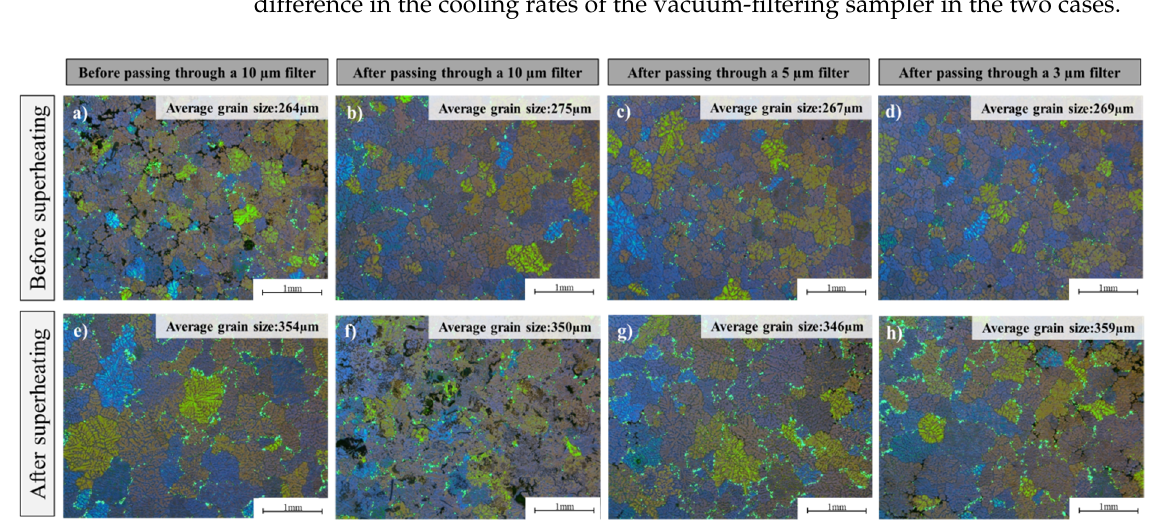
Figure 6. The microstructure of the CP AZ91 samples filtered through porous filters in the vacuum sampler: before superheating—( a ) before passing through a 10 μ m filter, ( b ) after passing through a 10 μ m filter, ( c ) after passing through a 5 μ m filter, ( d ) after passing through a 3 μ m filter and after superheating, ( e ) before passing through a 10 μ m filter, ( f ) after passing through a 10 μ m filter, ( g ) after passing through a 5 μ m filter, and ( h ) after passing through a 3 μ m filter.